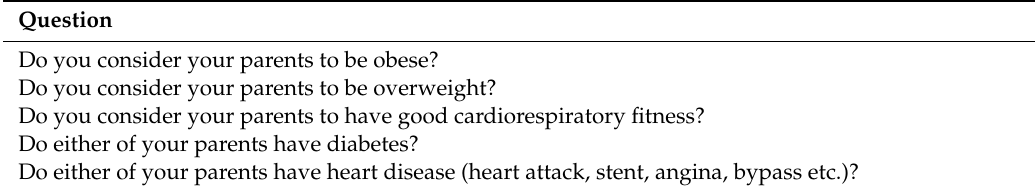
Table 1. Questions asked about parental cardiorespiratory fitness, body mass status, and diabetes and cardiovascular disease